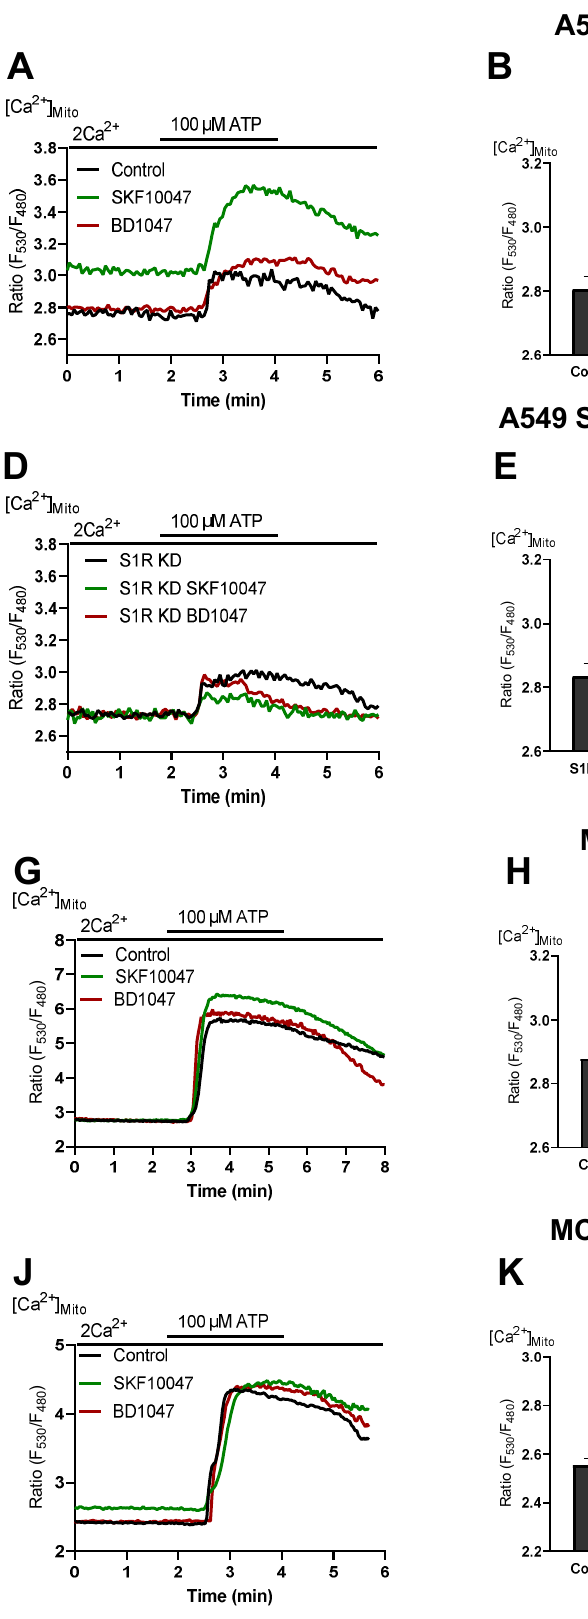
Figure 4. S1R activation increases basal and agonist-induced mitochondrial Ca 2+ uptake. ( A ) Repre- sentative traces of mitochondrial Ca 2+ dynamics measured with 4mtD3cpv for control (black), Con- trol+SKF10047 (green) and Control + BD1047 (red) in A549 cells. ( B ) Bar graphs with MEAN ±